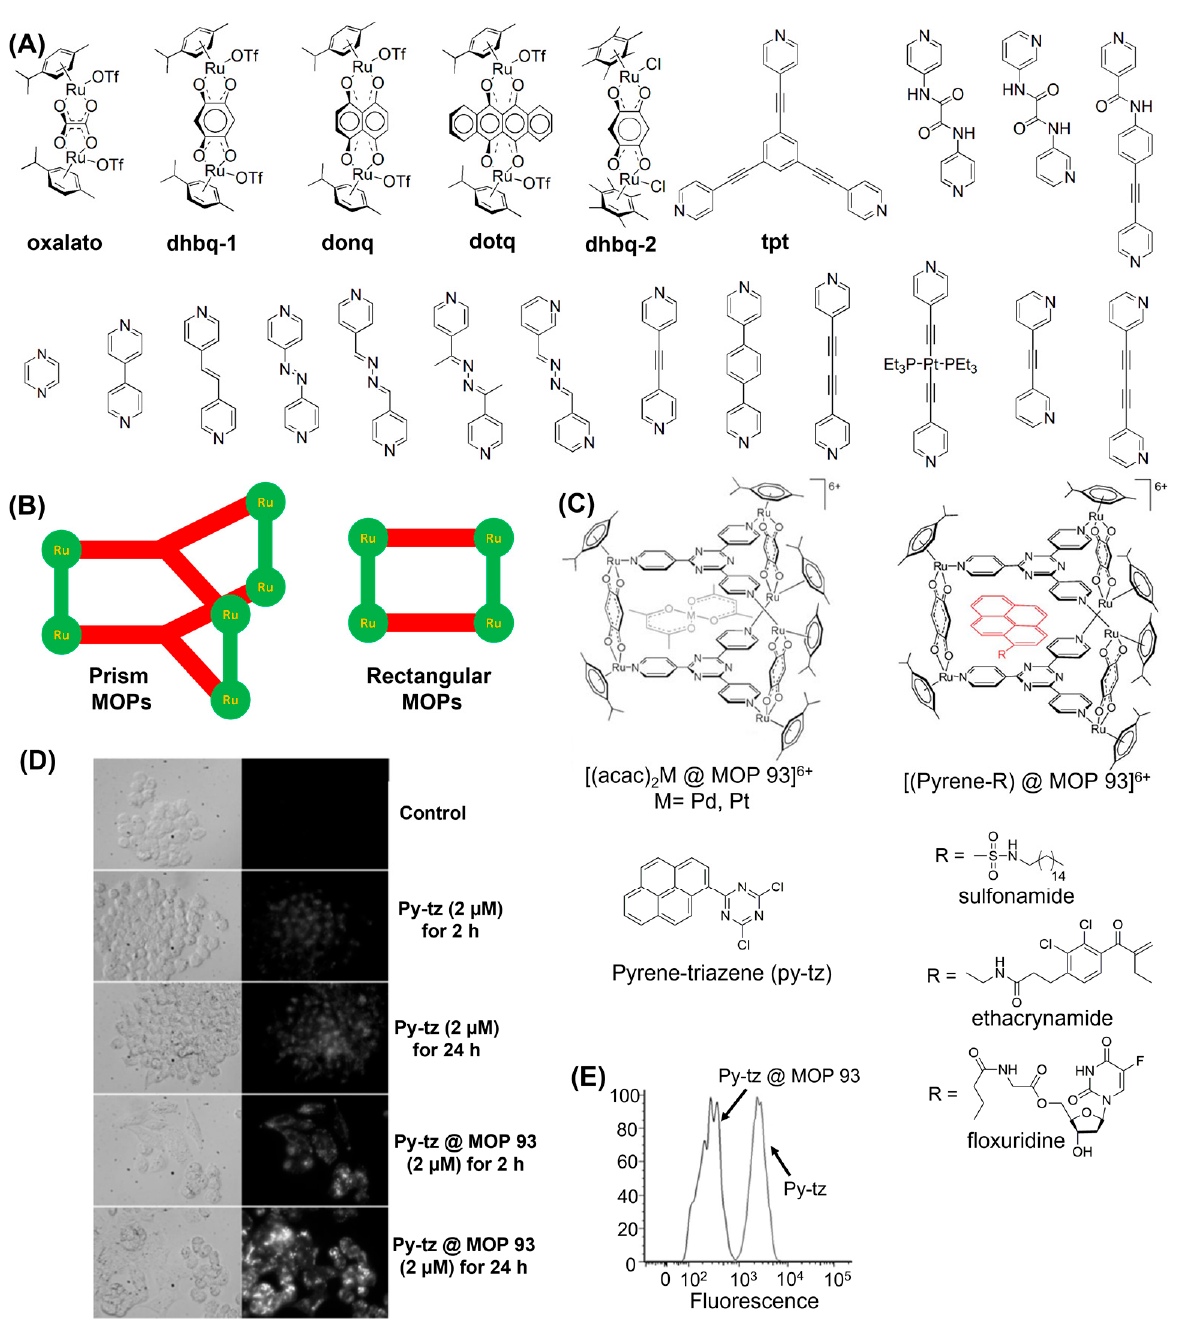
Figure 29. ( A ) Diruthenium molecular spacers (oxalato, dhbq-1, donq, dotq, dhbq-2) undergo self-assembly with ditopic and tritopic pyridyl donors to give metal organic polygons (MOPs). ( B ) Cartoon representation of [2 + 2] and [2 + 3] ruthenium-based MOP. ( C ) Molecular